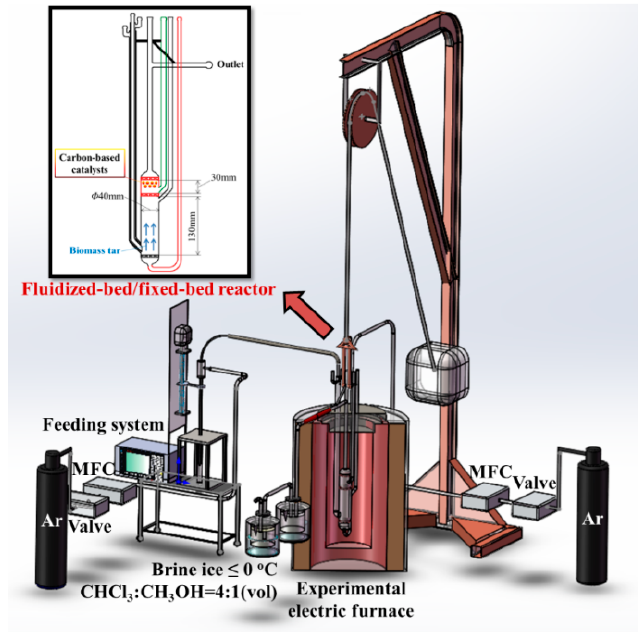
Figure 6. Experimental system of fixed-bed/fluidized-bed reactor.